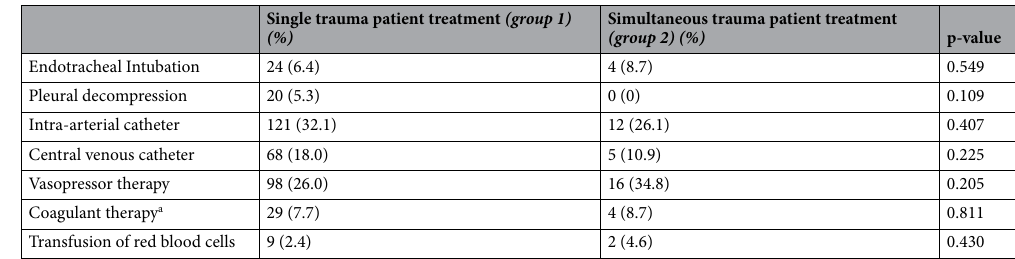
Table 5. Emergency procedures performed in the Trauma suite. a Coagulant therapy: calcium, tranexamic acid, coagula factors.